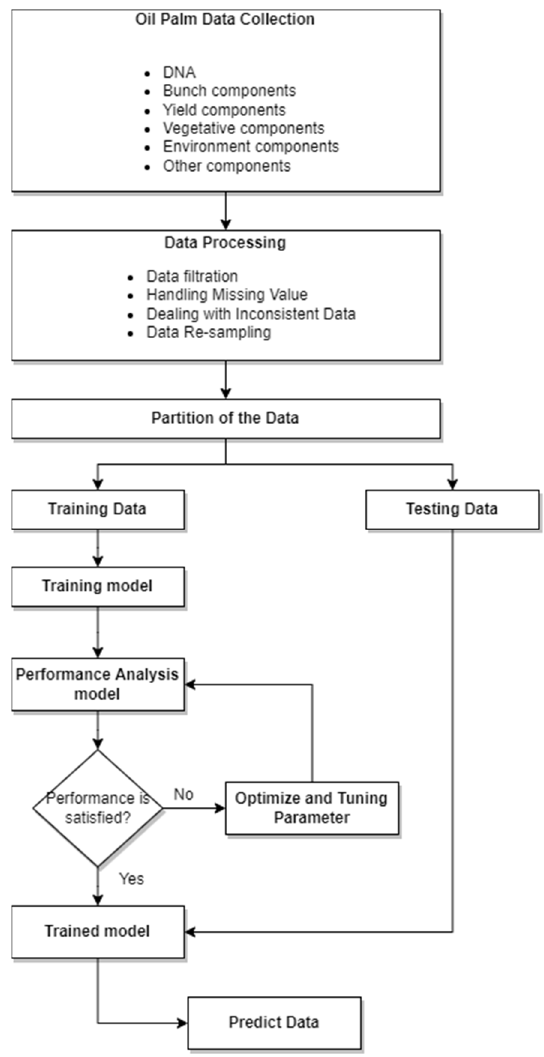
Figure 7. Identifying palm oil prediction flowchart.